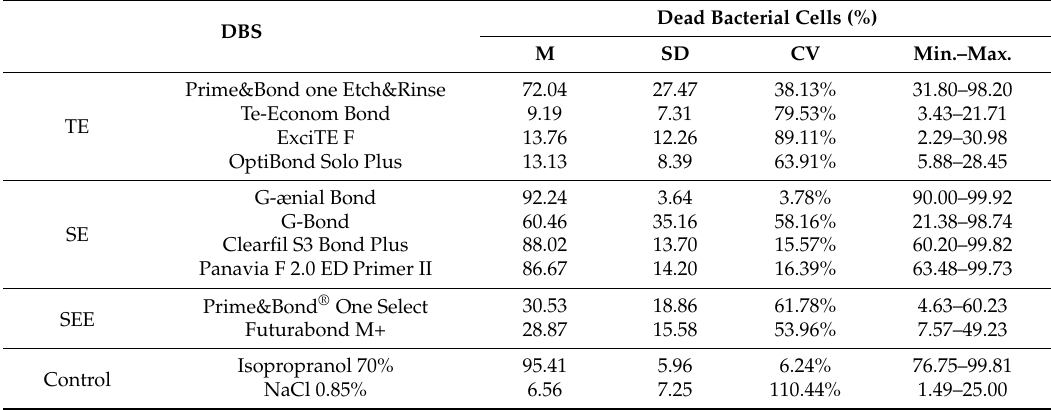
Table 1. Antibacterial activity of DBS against E. faecalis -Statistical parameters.